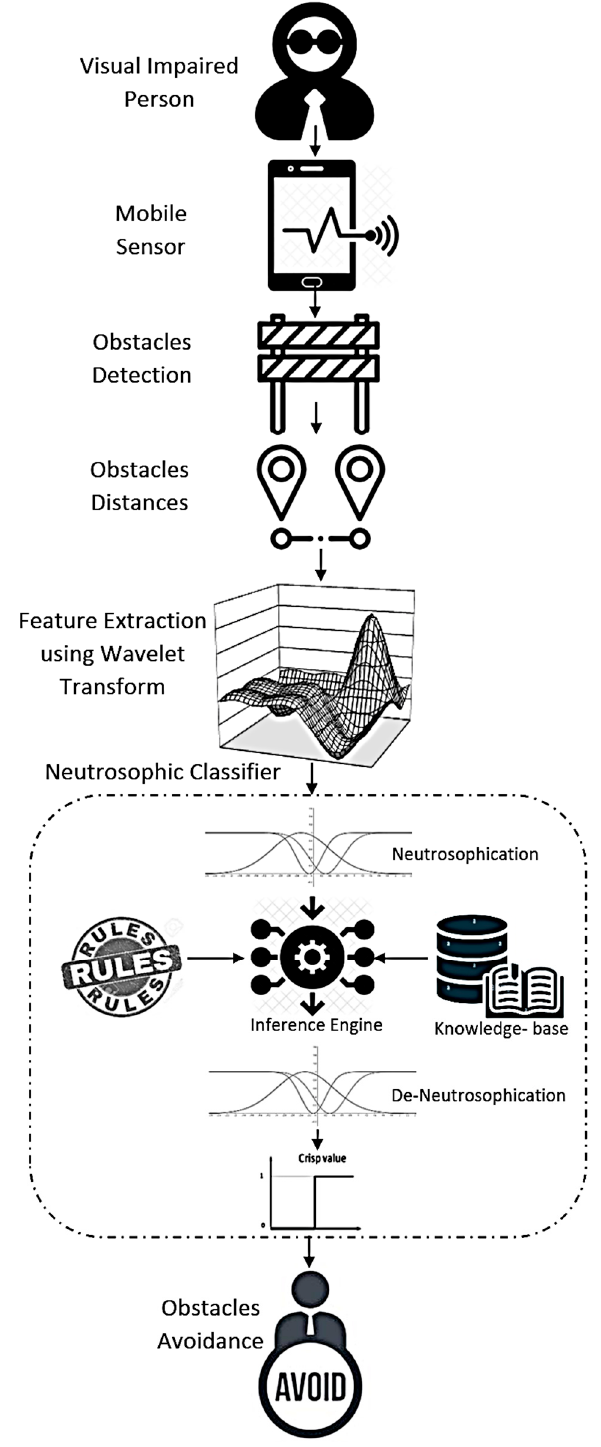
Figure 2. The technical description of the proposed framework's layout.